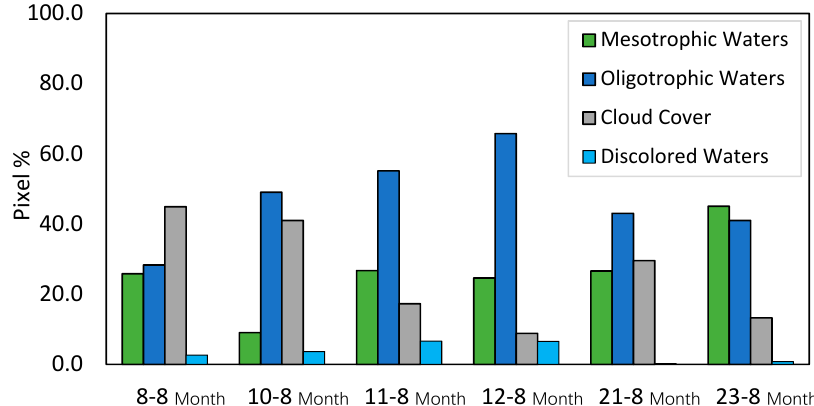
Figure 6. Pixel percentage of the observed area for the dates studied in August 2019 of different classes described above (see text). Pixel percentage of cloud cover (Not a Number (NaN)) and mesotrophic (Chla > 0.1 mg · m − 3 ), oligotrophic (Chla < 0.1 mg · m − 3 ), and discolored water (bb p at 443 nm > 0.0032 m − 1 ) values are represented along the y-axis. Note: percentages have been calculated on equivalent areas of 2.5 degrees in longitude and 1 degree latitude (area extraction 174.0 ◦ –176.5 ◦ W, 18.0 ◦ –19.0 ◦ S).